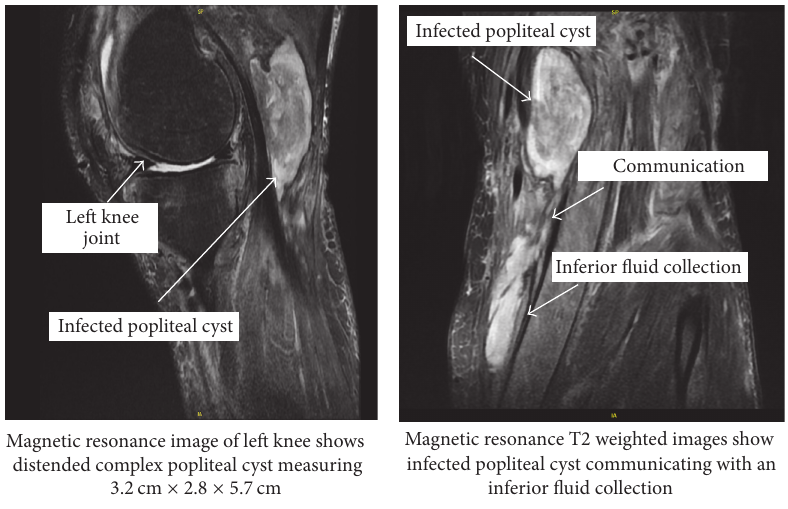
Figure 1: MRI images of left knee and infected fluid